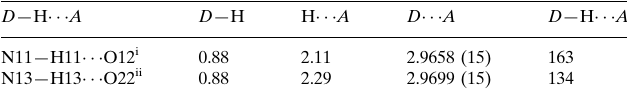
Hydrogen-bond geometry (A˚ , (cid:3)